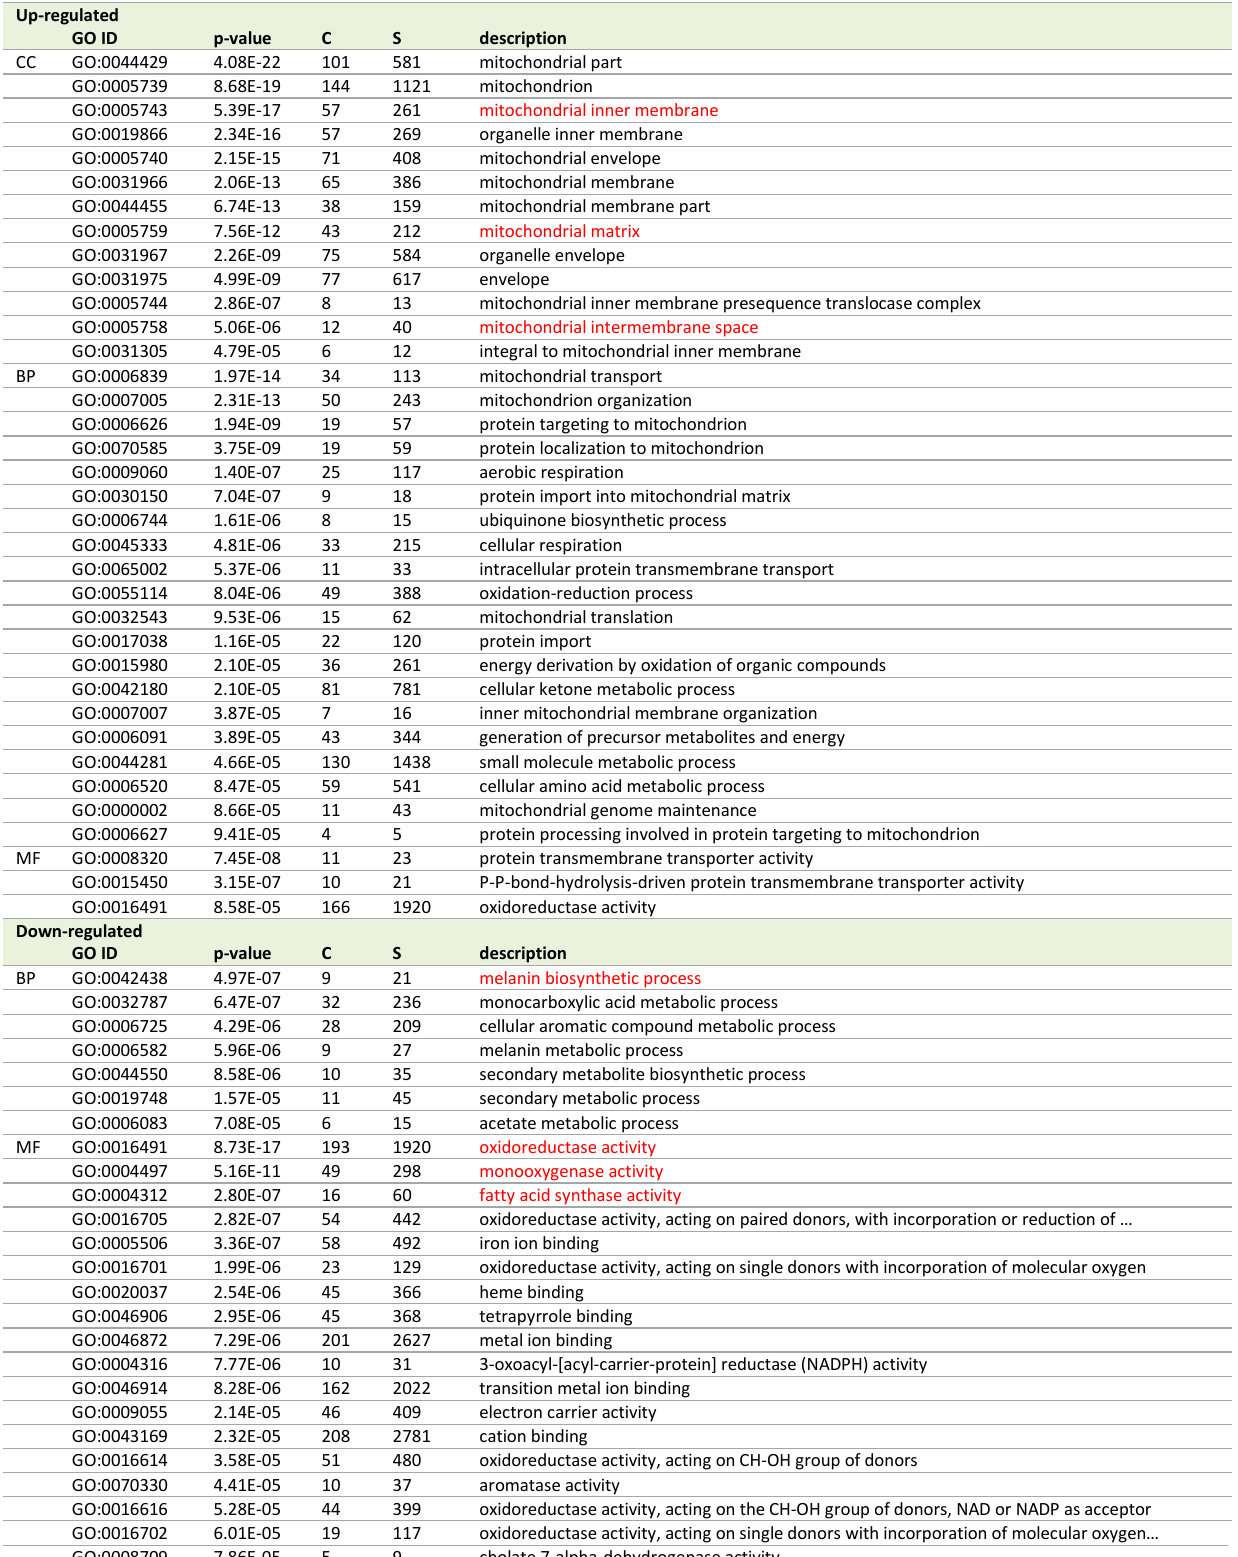
TABLE 2. GO enrichment analysis of transcriptome data of juvenile PQ-stressed P. anserina showing differential expression. Up-regulated GO